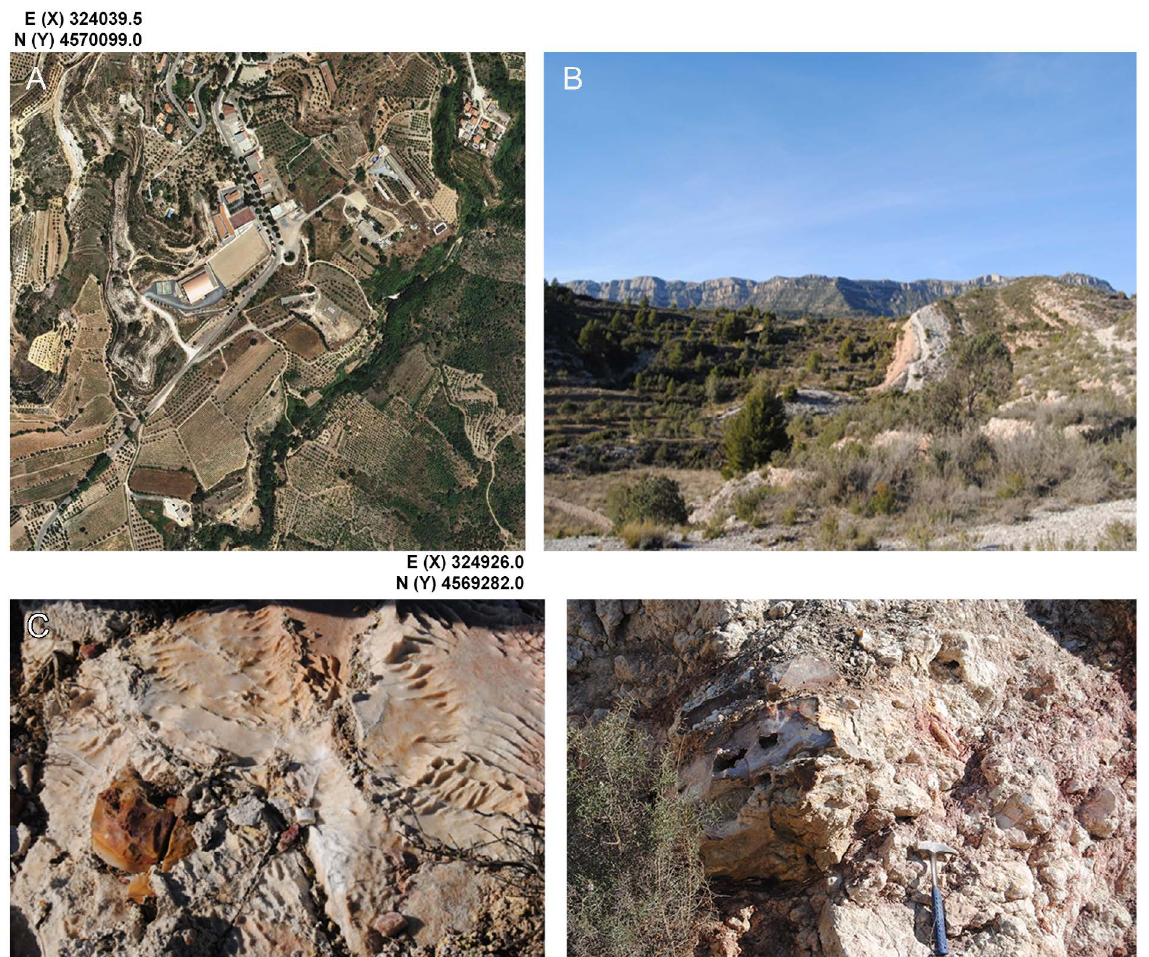
Figure 7. A) Area of the third stop of the Silica Road Trip (UTM 31N-ETRS89). B) General view of the